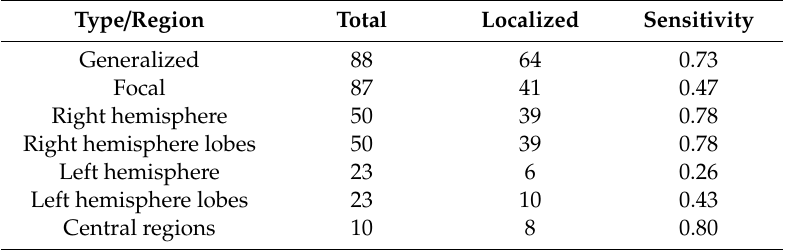
Table 5. Localization performance on the Karuniya dataset.